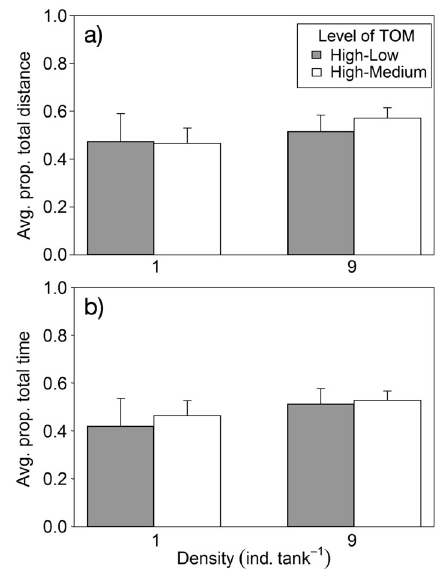
Fig. 4. (a) Average proportion of total distance travelled by California sea cucumbers Parastichopus californicus on the high total organic matter (TOM) side of the tank and (b) average proportion of total time spent moving on the high TOM side of the tank in response to the level of TOM and sea cucumber density (ind. tank −1 ). Results are for foraging experiments with 2 levels of TOM within a tank. Values are mean ± SE (n = 7). TOM levels: high, ~8%; medium, ~4.4.%; low,